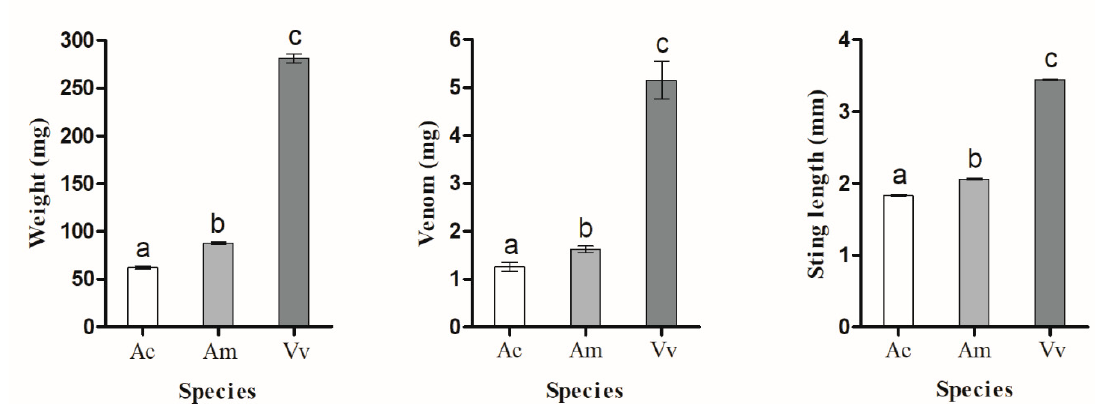
Figure 4. Comparisons between body mass, venom, and stinger length between A. cerana (Ac), A. mellifera (Ac), and V. velutina (Vv). Plots show the mean ± 1 standard error. Different letters indicate significant differences (Tukey HSD tests, p < 0.05).